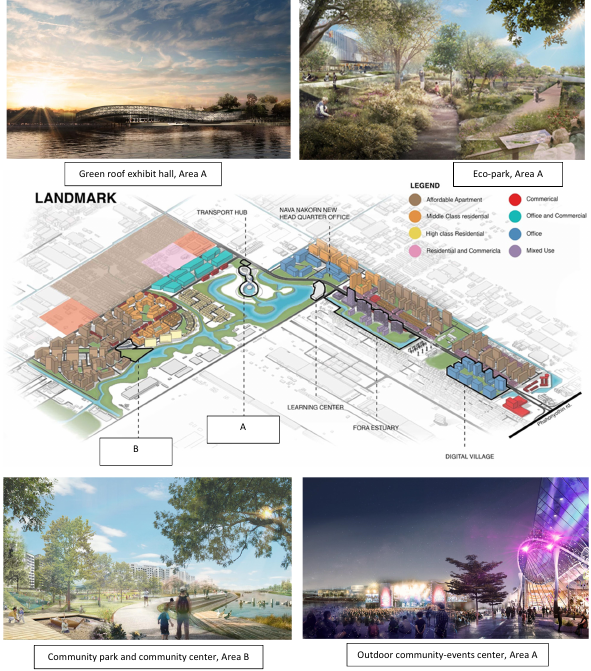
Figure 5. Visioning of green space and community space in the Nava Nakorn heartland with area A including a stormwater retention pond, a green-roof exhibit hall, an eco-park, and an outdoor community-events center. Area B represents a community park and community center. Graph- ics credits to Kanokwan Srisamer, Manus Janthik, Panyawat Terdkeat, Wipawee Khantikittikul, UD327